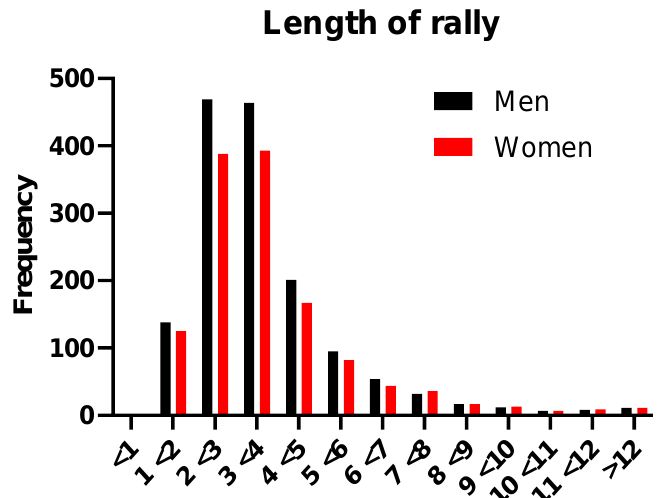
Figure 2. Rally duration distribution per gender. Table 3. Physiological and metabolic analysis: cardiac and LA responses during the SC.